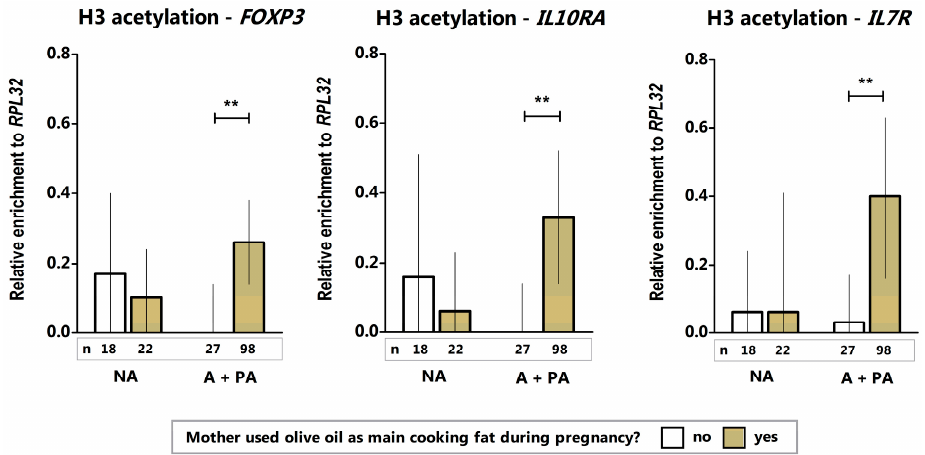
Figure 2. H3 histone acetylation levels (median with 95% confidence interval) in placenta according to the maternal use of olive oil as main cooking fat during pregnancy. NA denotes non-anthroposophic group; A, anthroposophic group; PA, partially anthroposophic group. Numbers of mothers with complete data on dietary exposures are presented below the bars. ** p value < 0.01.